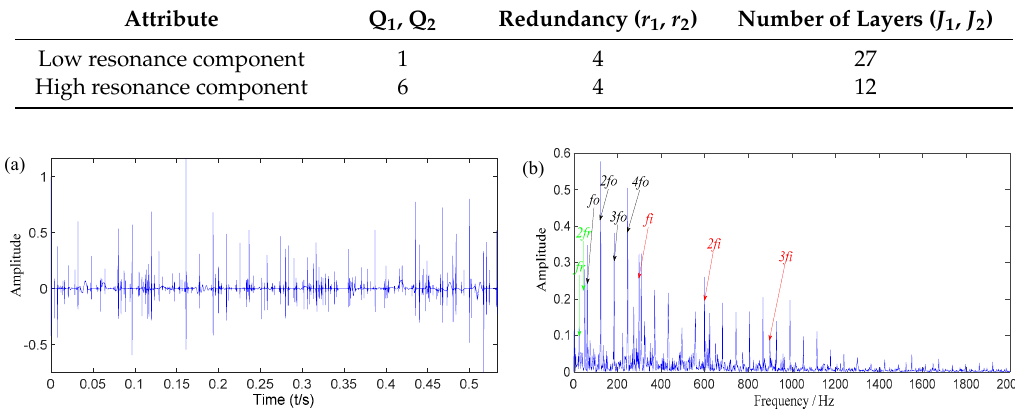
Figure 8. The analysis results of case 1 with the parallel dual-Q-factor bases sparse decomposition: ( a ) Low resonance component; ( b ) Hilbert envelope spectrum.